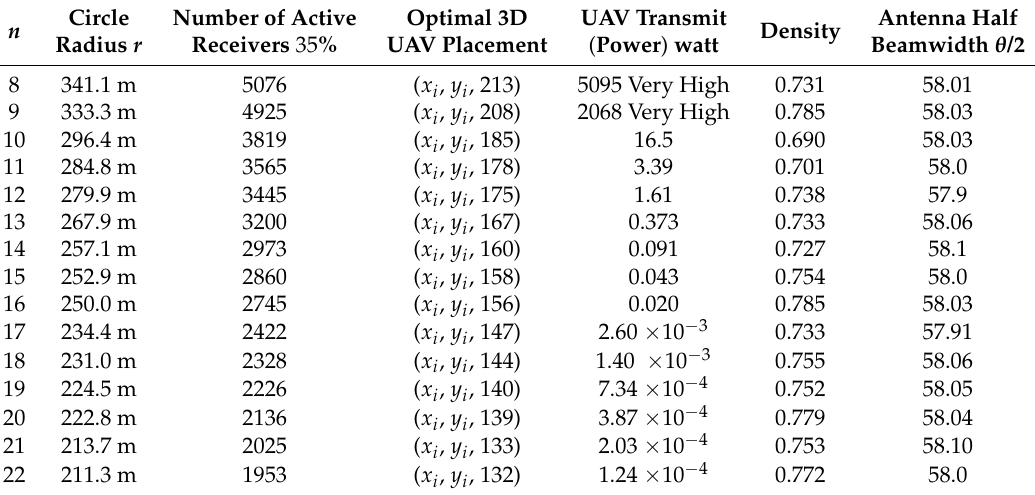
Table 4. Simulation results for packing n circles in a 2 km × 2 km square region ( x i , y i ) (cid:101) I = 1, . . ., n